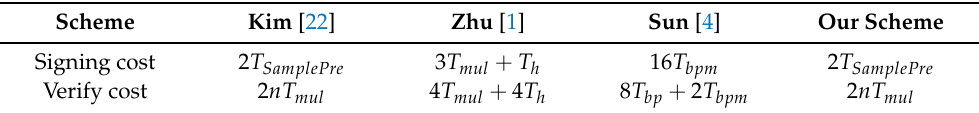
Table 1. A comparison of computation